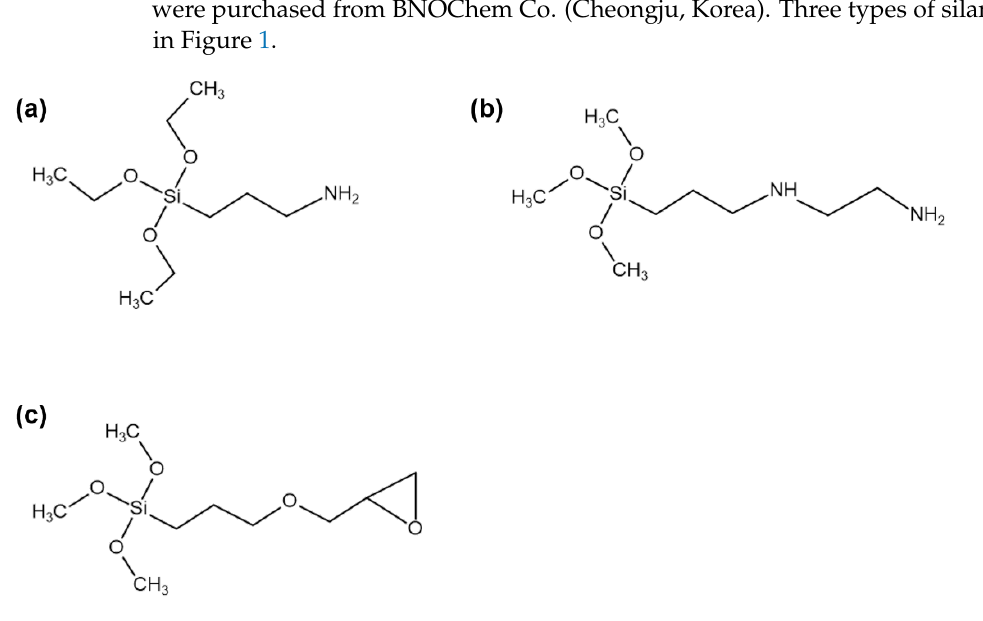
Figure 1. Silane structures: ( a ) aminopropyltriethoxysilane (A1S), ( b ) aminoethylaminopropyltrimethoxysilane (A2S) and ( c ) 3-glycidoxypropyltrimethoxysilane (ES).